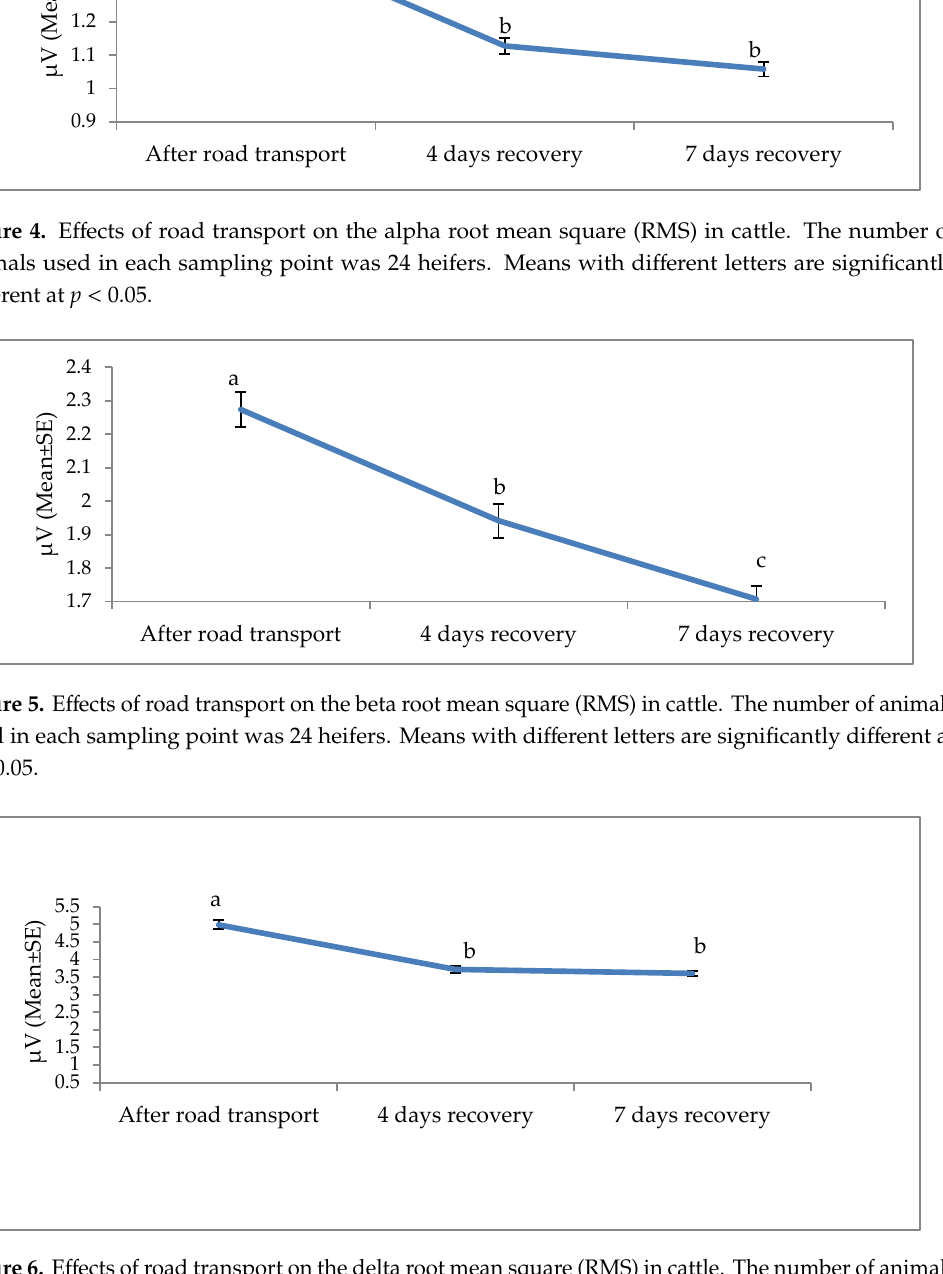
Figure 7. Effects of road transport on the theta root mean square (RMS) in cattle. The number of animals used in each sampling point was 24 heifers. Means with different letters are significantly different at p < 0.05. Figure 8. Effects of road transport on total power (ptot) of the EEG in cattle. The number of animals used in each sampling point was 24 heifers. Means with different letters are significantly different at p < 0.05.